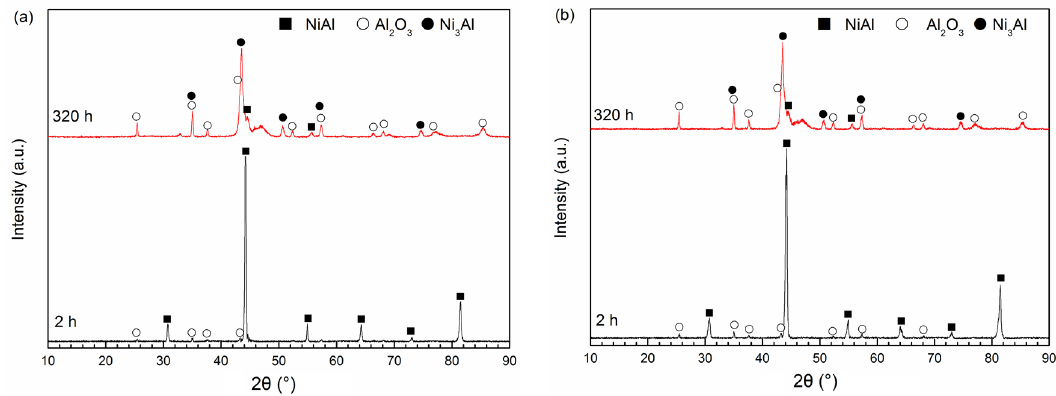
Figure 8. XRD patterns of the coatings after isothermal oxidation at 1100 °C for 2 h and 320 h: ( a ) PtAl; ( b ) PtZrAl.